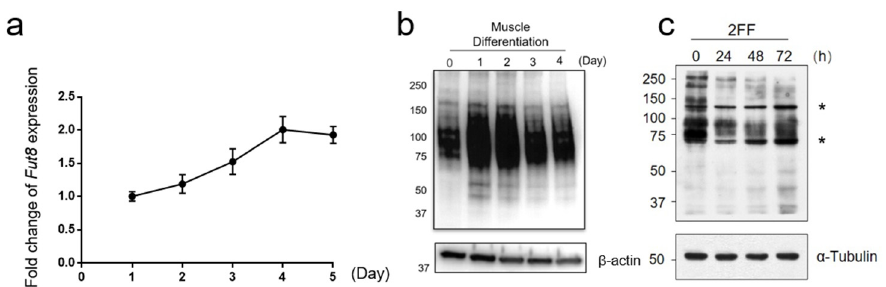
Figure 6. Altered expression and fucosylation of Fut8 in C2C12 cells ( a ) Fut8a expression during C2C12 cell differentiation. Relative control normalized by r18 on day 1. (b) Lectin blot, with AAL and anti- β -actin, of C2C12 cells with induced muscle differentiation. ( c ) Lectin blot, with AAL and anti- α -tubulin, of C2C12 cells treated with 1 mM 2-Fluorofucose (2FF). * Nonspecific band.